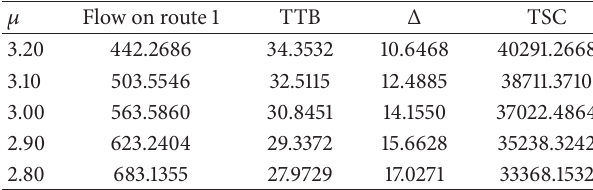
Table 5: Results with different 𝜇 at RUE.